Question: What direction does the quantity move in — increasing or decreasing?
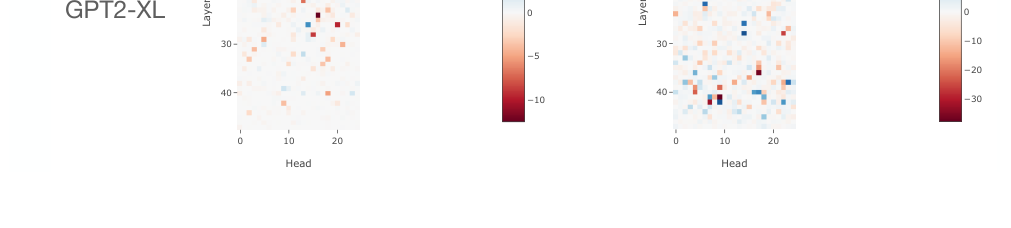
Answer: increasing